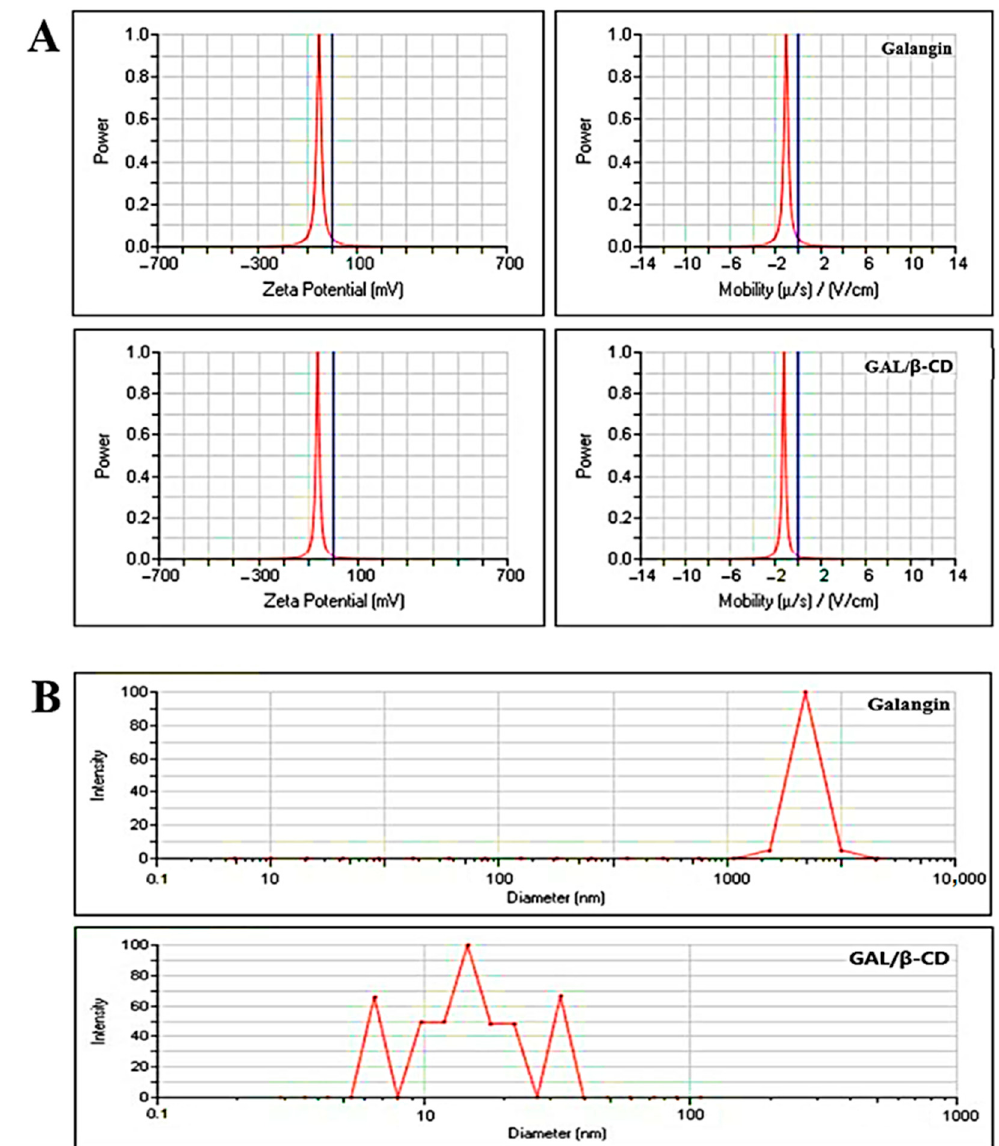
Figure 5. ( A ) Zeta potential analysis and ( B ) DLS analysis for pure galangin and GAL/ β -CD.